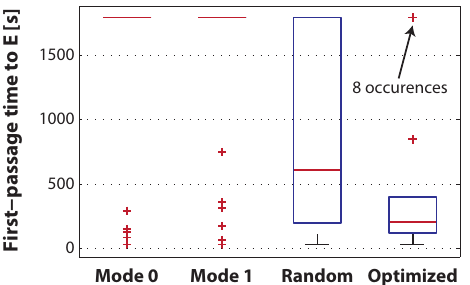
Figure 5. Box plot of the first-passage time to the target structure E obtained over 40 runs of 30 min each for Experiments I to IV. On each box, the central mark is the median; the edges of the boxes are the first and third quartile; the whiskers extend to the most extreme data points not considered outliers; and outliers are plotted individually. Both Experiments I (Mode 0 only) and II (Mode 1 only) exhibit a poor performance due to the unfavorable exploration vs. exploitation balance when using a unique mode of agitation. The mean/median first-passage time of the optimized experiment (IV) is 524/205 s versus 930/612 s for the randomized experiment (III). A Mann–Whitney test rejects the null hypothesis of the two distributions of first-passage times being from the same distribution with equal medians with a p -value of 5.8 × 10 − 3